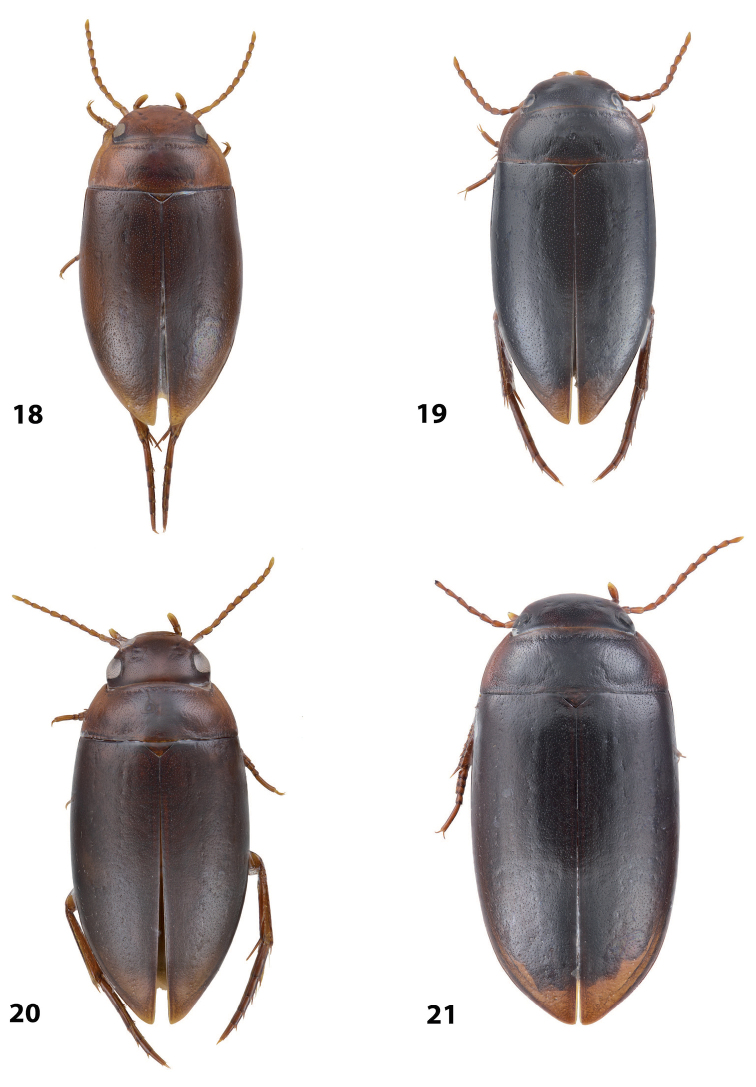
Habitus and coloration 18Exocelinapseudopusilla sp. n. 19E.simbaiensis sp. n. 20E.menyamya sp. n. 21E.ambua sp. n.